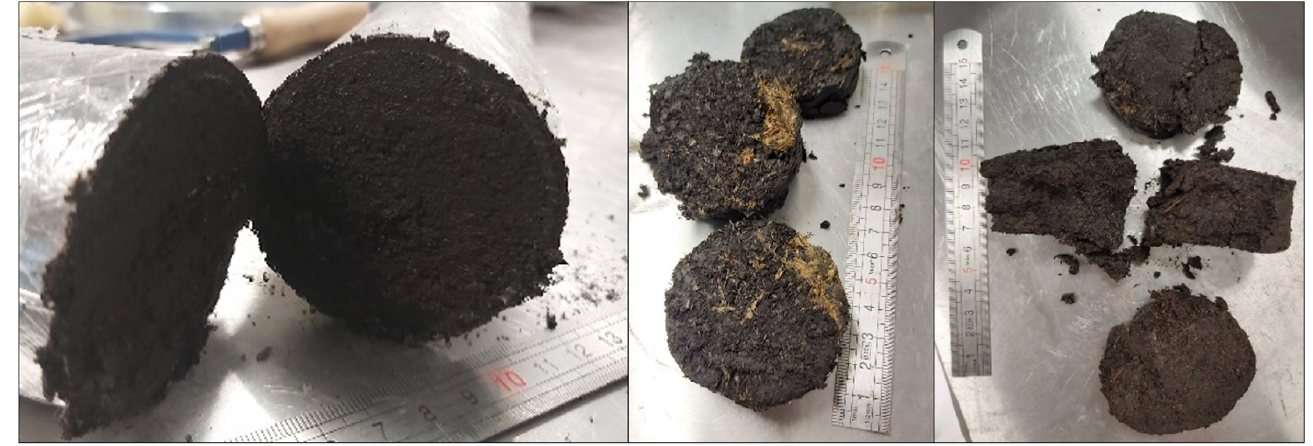
Figure 1. Example photos of peat samples of various structure from different locations in the Biebrza valley area.